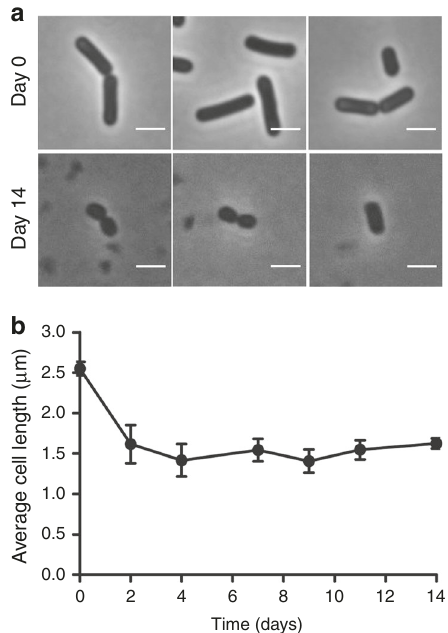
Fig. 2 Cell length reduction during deep starvation. a Phase contrast images of B. subtilis Δ spoIIE cells in the beginning (day 0), and after 14 days of incubation in starvation buffer. Scale bar is 2 µ m. b Average cell length. Average and standard deviation from three independent experiments are depicted. Approximately 100 cells were measured for every